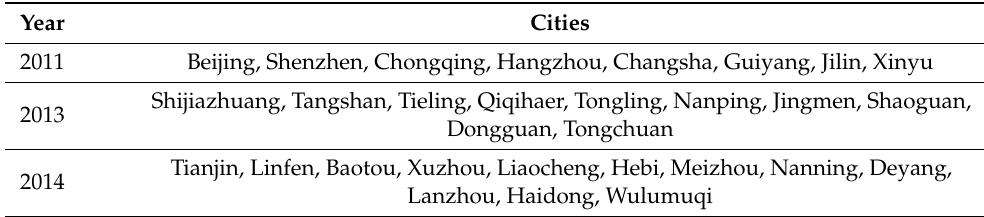
Table 1. Demonstration cities of ECER (Energy Conservation and Emission Reduction) fiscal